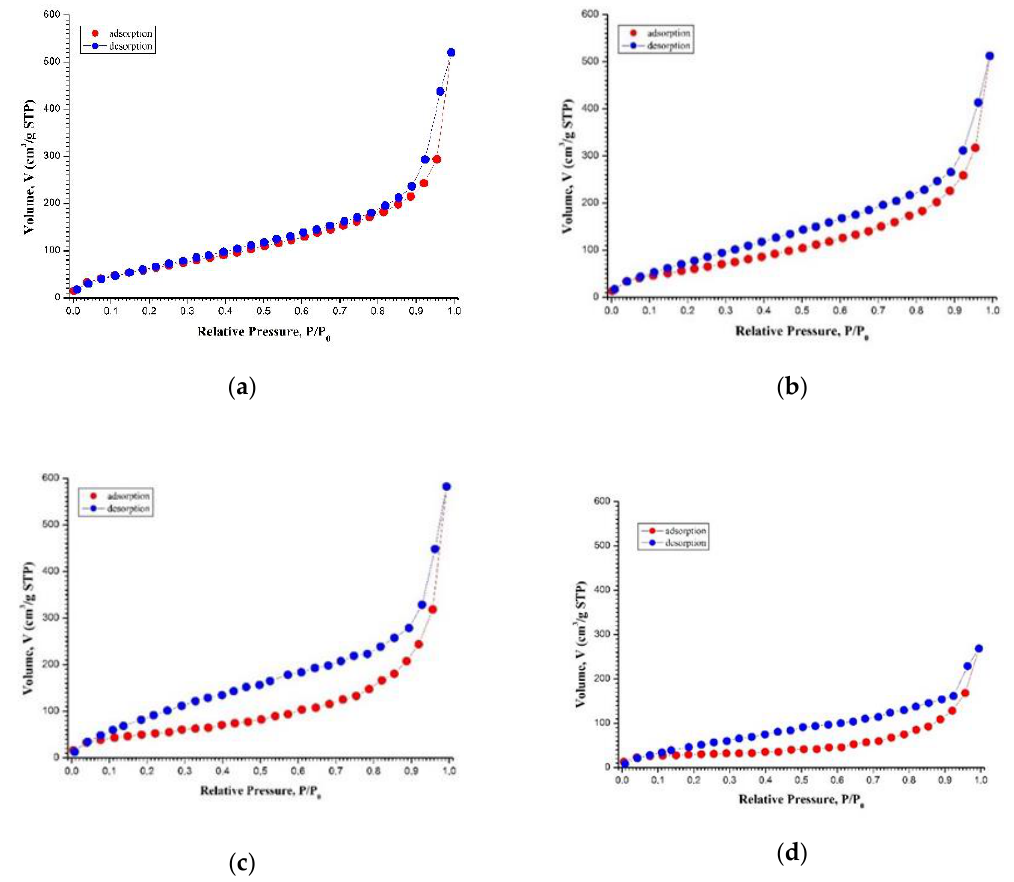
Figure 4. Nitrogen adsorption/desorption isotherms for supercritically dried native nano-gel film (NGF) ( a ) and bacterial cellulose (BC) samples after the biodegradation under the action of cellobiohydrolase from S. candidum 3C for 120 ( b ), 240 ( c ) minutes, and 24 h ( d ).